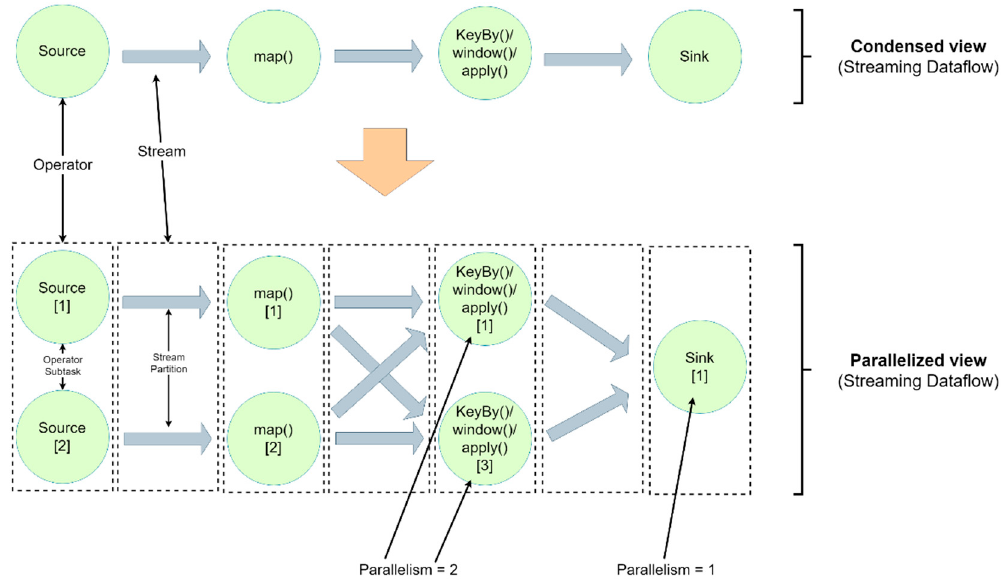
Figure 6. Subtask concept based on the condensed and parallelized view of the streaming dataflow.